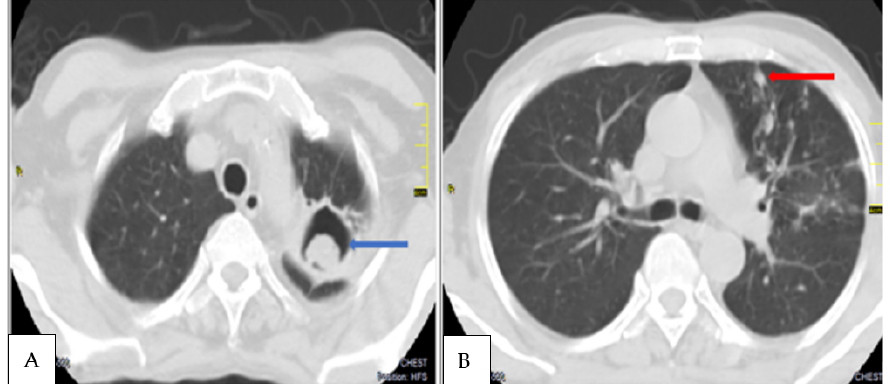
Figure 2. Axial non contrast CT scan, coronal reformatted lung, and axial mediastinal windows of the chest of the patient diagnosed with CPA at T 1 ( A ). Extensive left lung traction bronchiectasis (blue arrows) with ipsilateral lung volume loss, left apical lung cavity with intracavitary material (yellow arrow); ( B ) left apical lung pericavitary pleural thickening (red arrow).